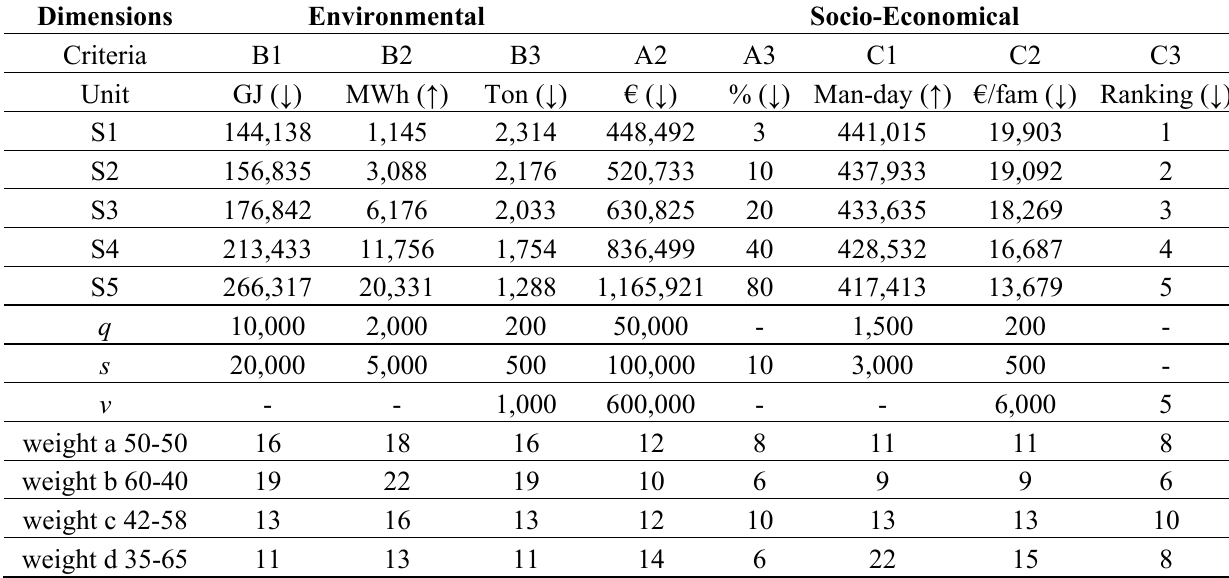
Table 16. Evaluations of the strategies, thresholds of indifference ( q ), preference ( s ) and veto ( v ) and weighting scenarios of the dimensions and criteria (%).